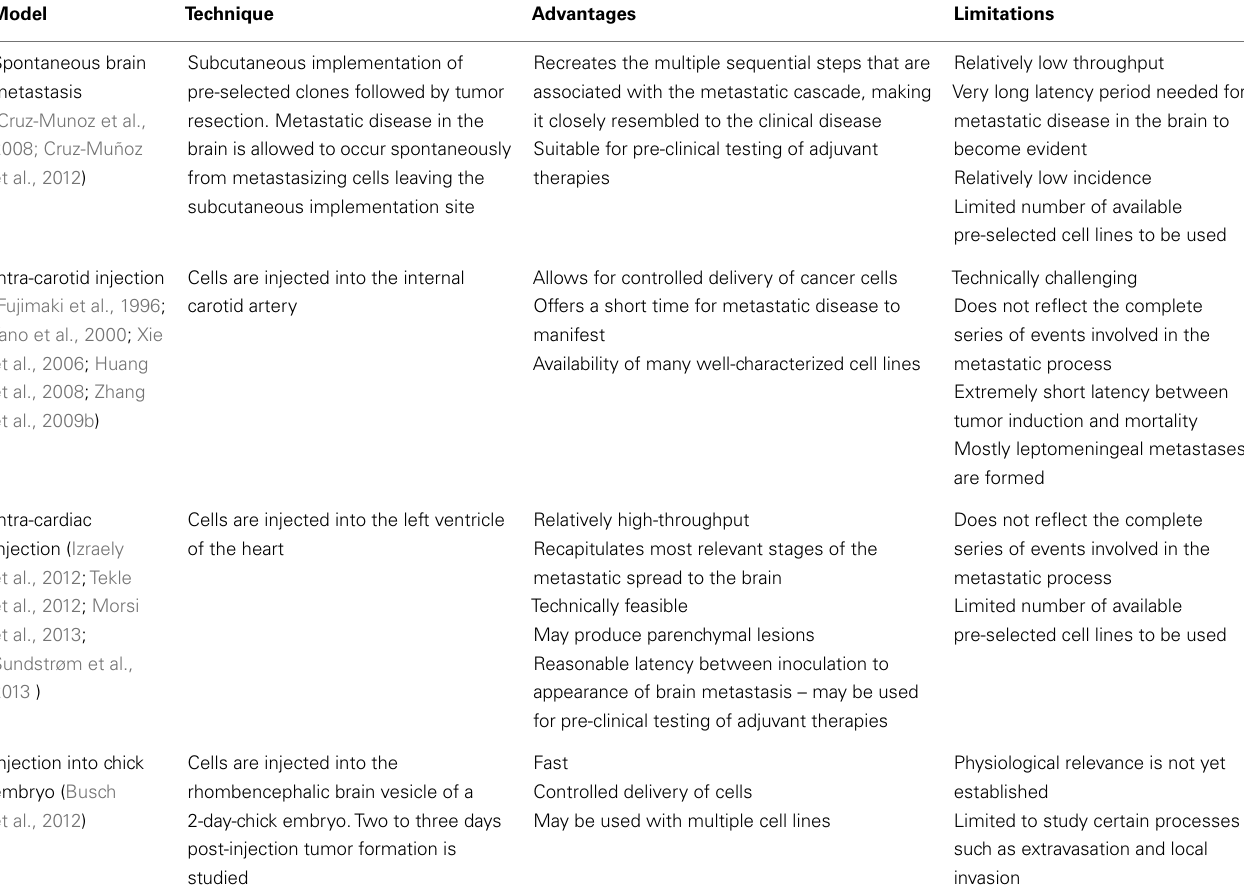
Table 1 | In vivo models of melanoma brain